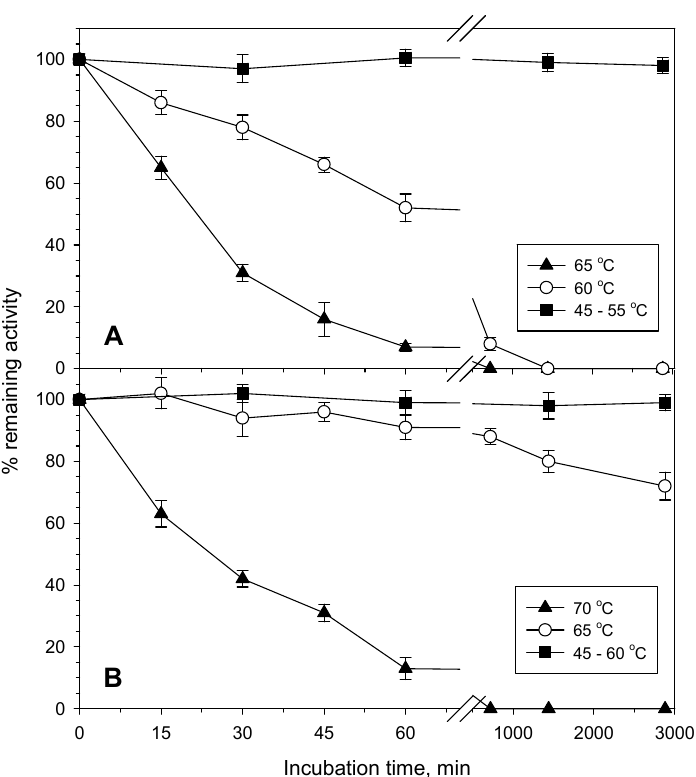
Figure 2. Effect of temperature (( A ) determined at pH 4) and pH (( B ) determined at 50 °C) on the activity of the purified PvXyn11A ( ▲ ) and PvXyd3A (  ) of B. spectabilis ATHUM 8891.